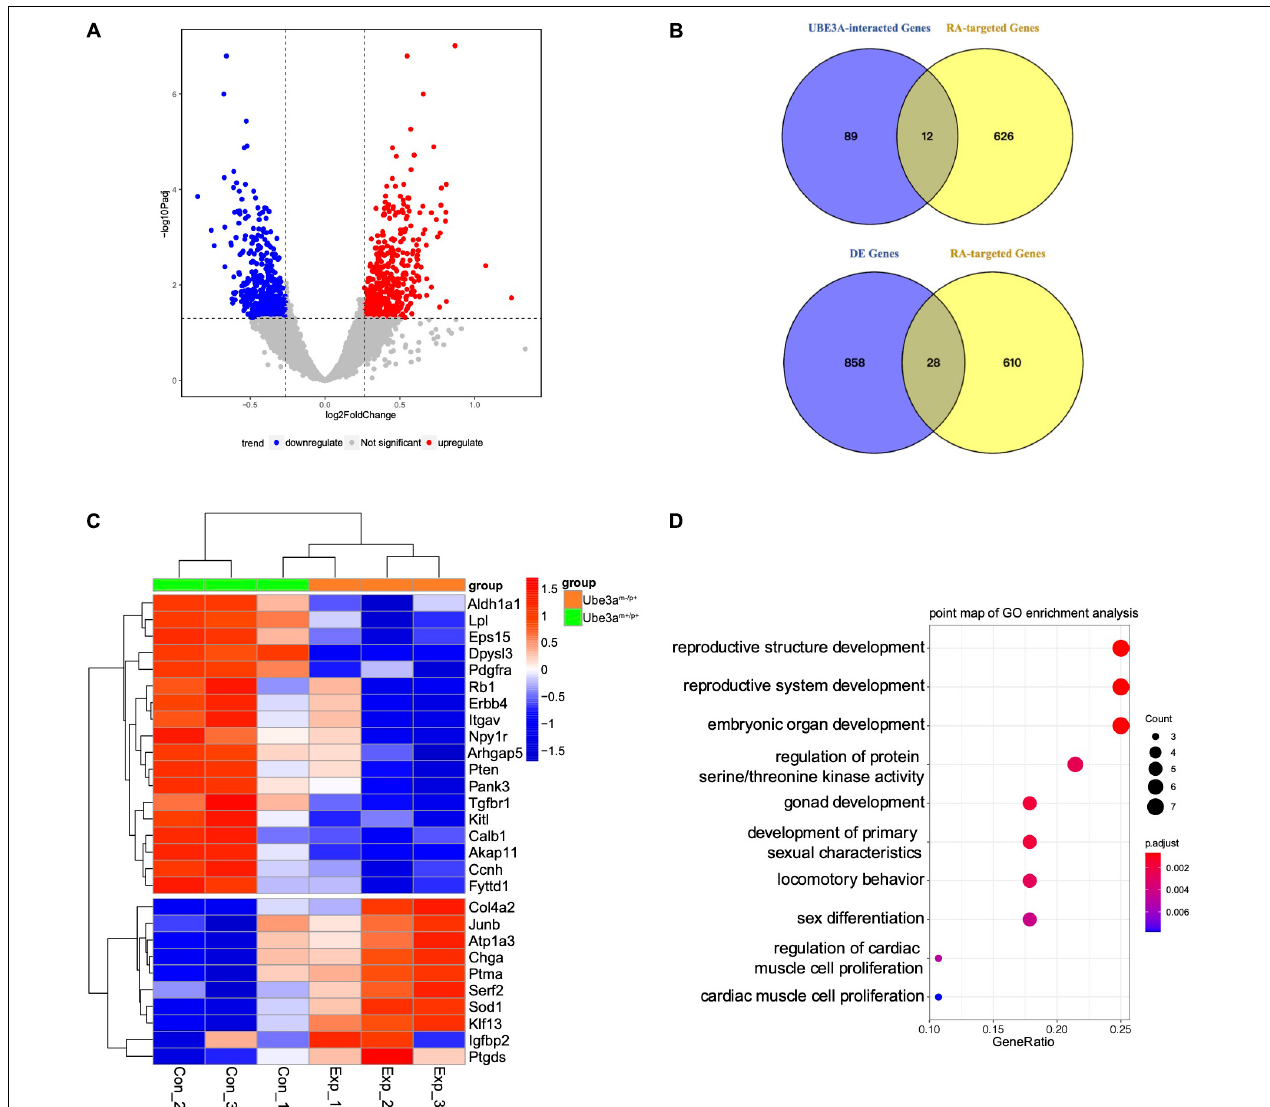
FIGURE 1 | Gene expression profiling in the hippocampus of mice. (A) Volcano plot analysis from the hippocampus of Ube3a m − / p + mice and Ube3a m + / p + mice (Foldchange > 1.2; P < 0.05). (B) Venn analysis was used for enrichment between the most related to UBE3A and RA-regulated genes or differentially expressed genes. (C) Comparison of convergent differential RA-targeted genes expression between Ube3a m + / p + and Ube3a m − / p + mice. The mean numbers of reads were used. Mouse samples were divided into two groups: Ube3a m + / p + mice ( n = 3) and Ube3a m − / p + mice ( n = 3). (D) Enriched Biological Process pathway in GO analysis ( P <